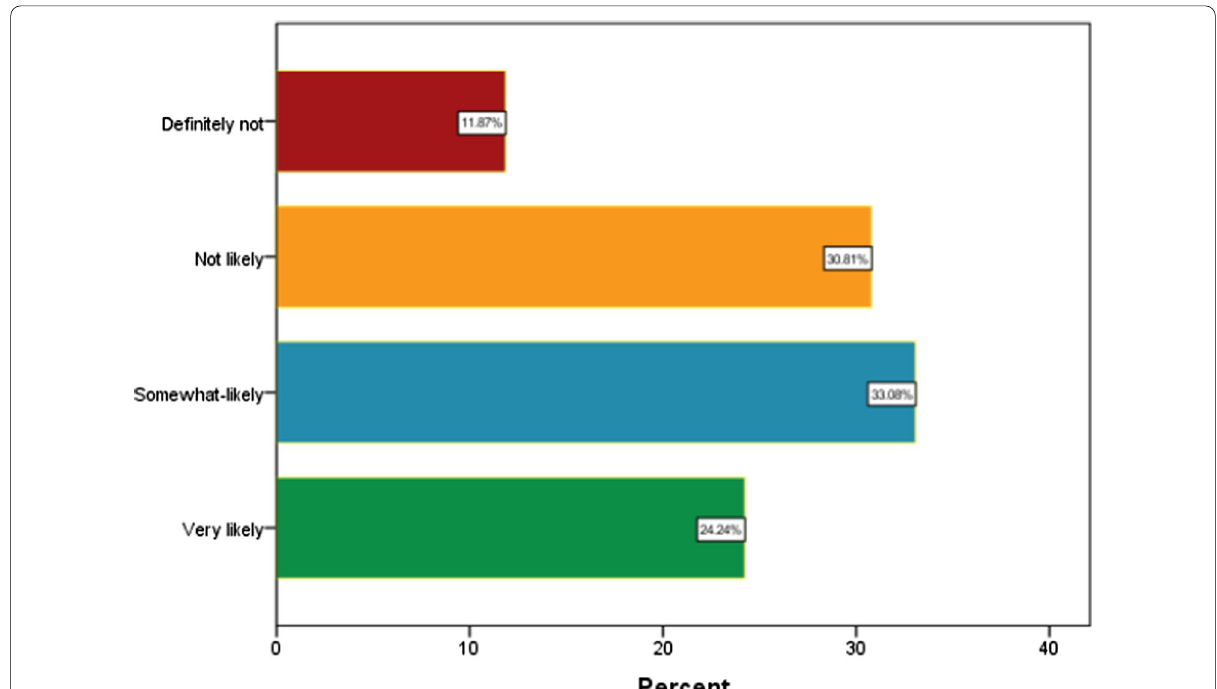
Fig. 1 Likelihood of COVID‑19 vaccine acceptance/refusal by Bangladeshi parents for children with neurodevelopmental